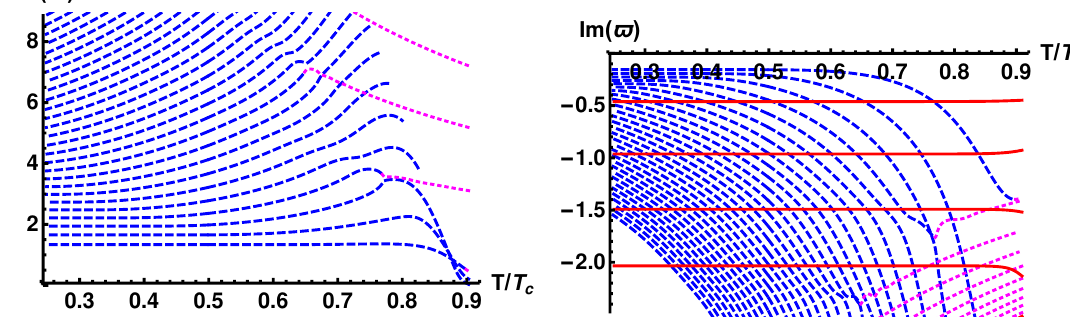
Figure 6 . The temperature dependence of the QNMs in the glued background at e Q = 0 . 8 and X = − 0 . 47 . Left: real parts. Right: imaginary parts. The red solid curves, blue dashed curves, and the magenta dotted curves are the imaginary near-horizon modes, the complex modes, and the AdS modes,